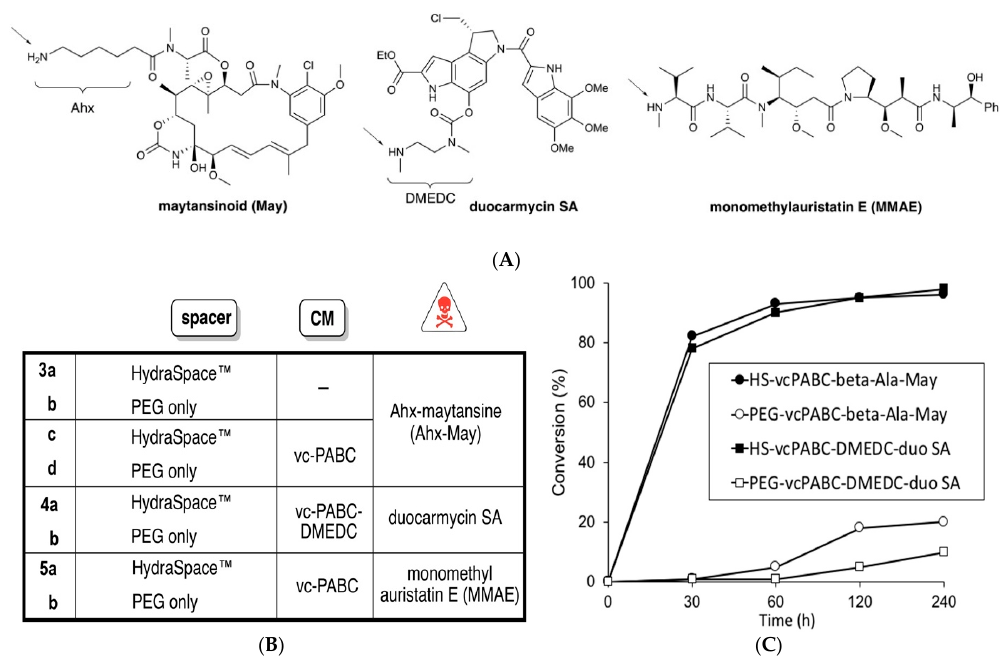
Figure 2. ( A ) Structures of payloads with point of attachment indicated with arrow. The 6-aminohexanoyl (Ahx) remains bound to the maytansinoid after release, while the N ’, N -dimethylethylenediaminocarbonyl (DMEDC) moiety on duocarmycin SA is designed for self-elimination by cyclization; ( B ) BCN constructs used in this study for conjugation to trastuzumab- 1 or brentuximab- 1 ; ( C ) Conjugation efficiency of trastuzumab- 1 with BCN-payload constructs based on maytansinoid (May) or duocarmycin SA (duo SA), with PEG only (PEG) or with sulfamide moiety (HS). In each case, three equivalents of BCN-payload were used with regard to trastuzumab- 1 (1.5 equivalent per azide).